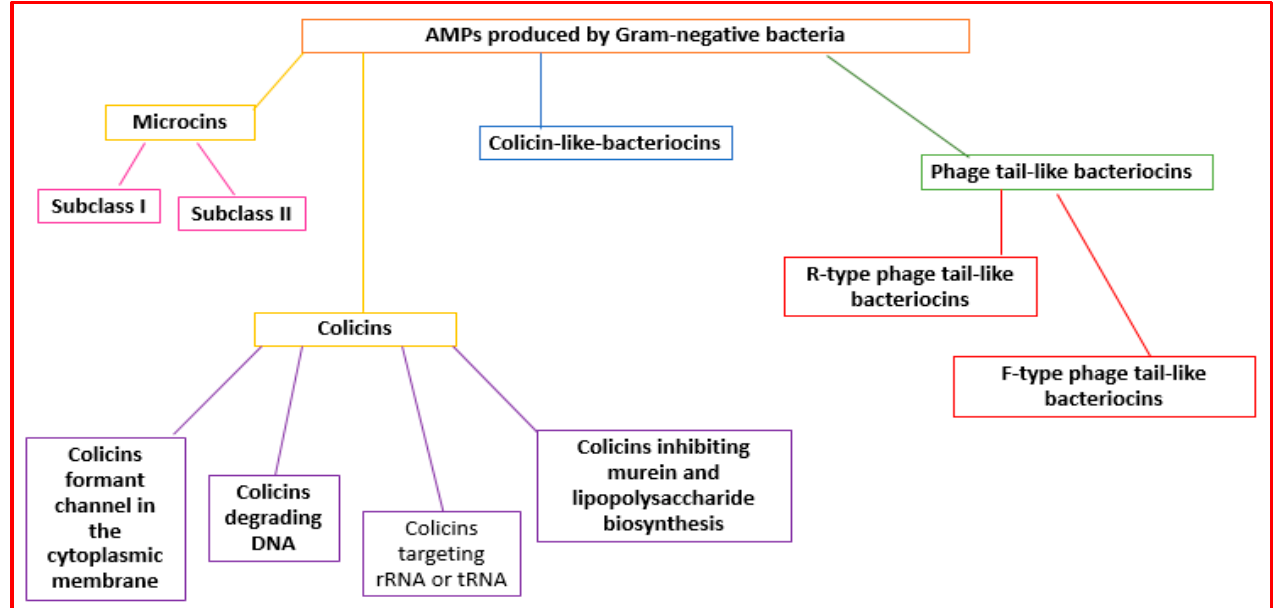
Figure 3. Classification of the AMPs produced by Gram-negative